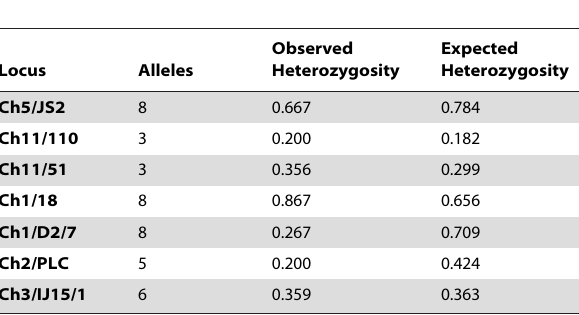
Table 2. Polymorphisms and heterozygosity of T. brucei at the Coˆte d’Ivoire focus (N